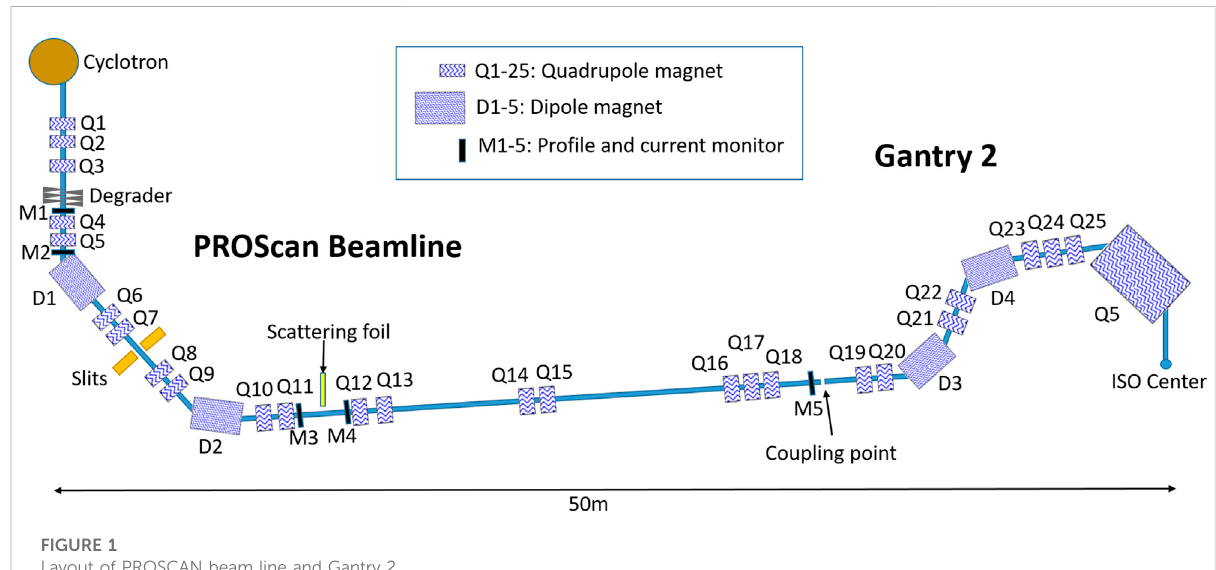
FIGURE 1 Layout of PROSCAN beam line and Gantry